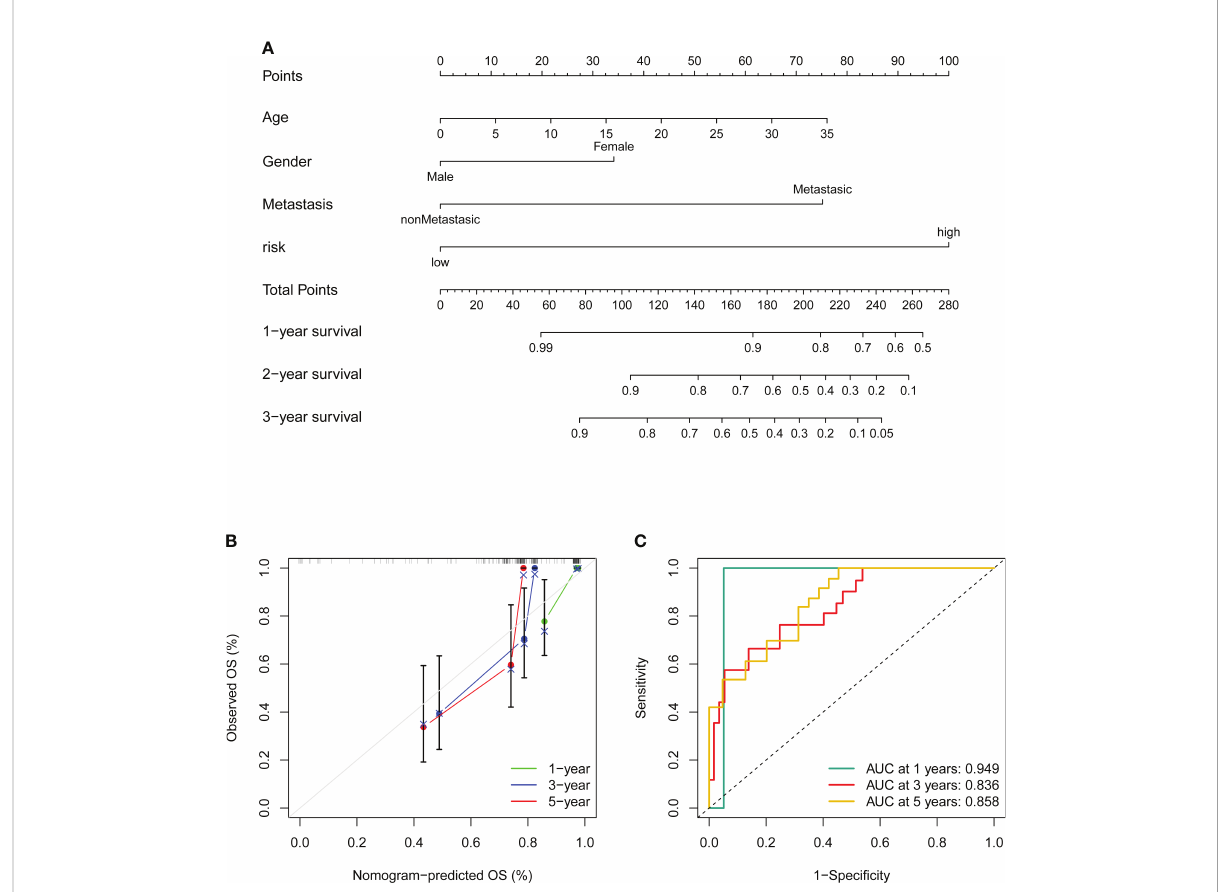
FIGURE 8 Construction and validation of a nomogram. (A) Nomogram for predicting the 1-, 3-, and 5- overall survival of OS patients. (B) Calibration curves of the nomogram for predicting the 1-, 3-, and 5- overall survival of OS patients. The dashed diagonal line in grey colour represents the ideal nomogram. (C) The ROC curves of the nomogram estimate the prognostic value of the